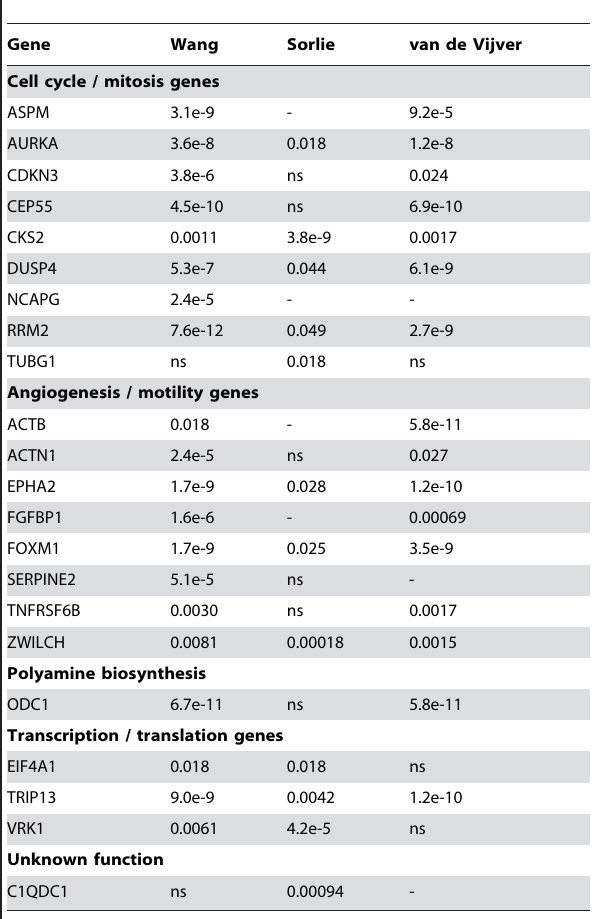
Table 2. ER association of the 22 individual 3D signature genes in three patient datasets (Welch t-test p values with false positive multigene correction).